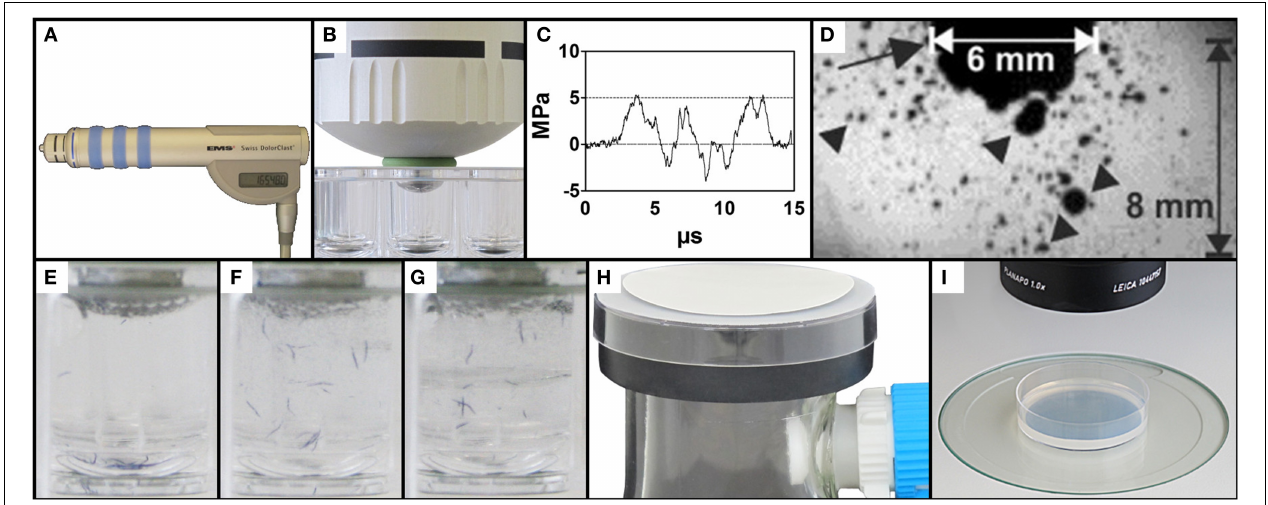
FIGURE 1 | Exposure of C. elegans to therapeutic shock waves. (A) Handpiece of the Swiss DolorClast therapeutic shock wave device used in the present study. (B) Placement of the shock wave device 6-mm applicator tip and specialized O-ring in a single well of a 96-well plate. (C) Pressure as a function of time of the shock waves applied in the present study. Measurements were taken at 5mm distance to the applicator with a fiber optic probe laser hydrophone (FOPH, 2000; RP Acoustics, Leutenbach, Germany) coupled to an oscilloscope (LeCroy 9361; LeCroy, Chestnut Ridge; NY). (D) Cavitation bubbles (arrowheads) produced by the shock waves applied in the present study. The arrow points to the 6-mm applicator of the shock wave device. The size of the cavitation field generated by the shock wave device as operated in the present study